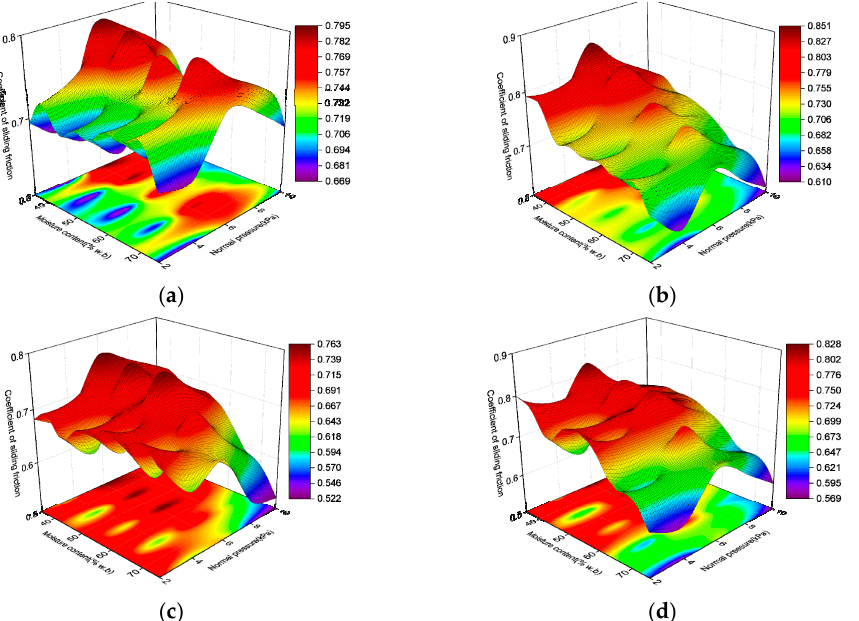
Figure 7. Effects of the moisture content and normal pressure on the coefficient of sliding friction of extrusion-exploded straw (( a ): extrusion-exploded wheat straw on mild steel; ( b ): extrusion-exploded wheat straw on aluminum; ( c ): extrusion-exploded rice straw on mild steel; ( d ): extrusion-exploded rice straw on aluminum).